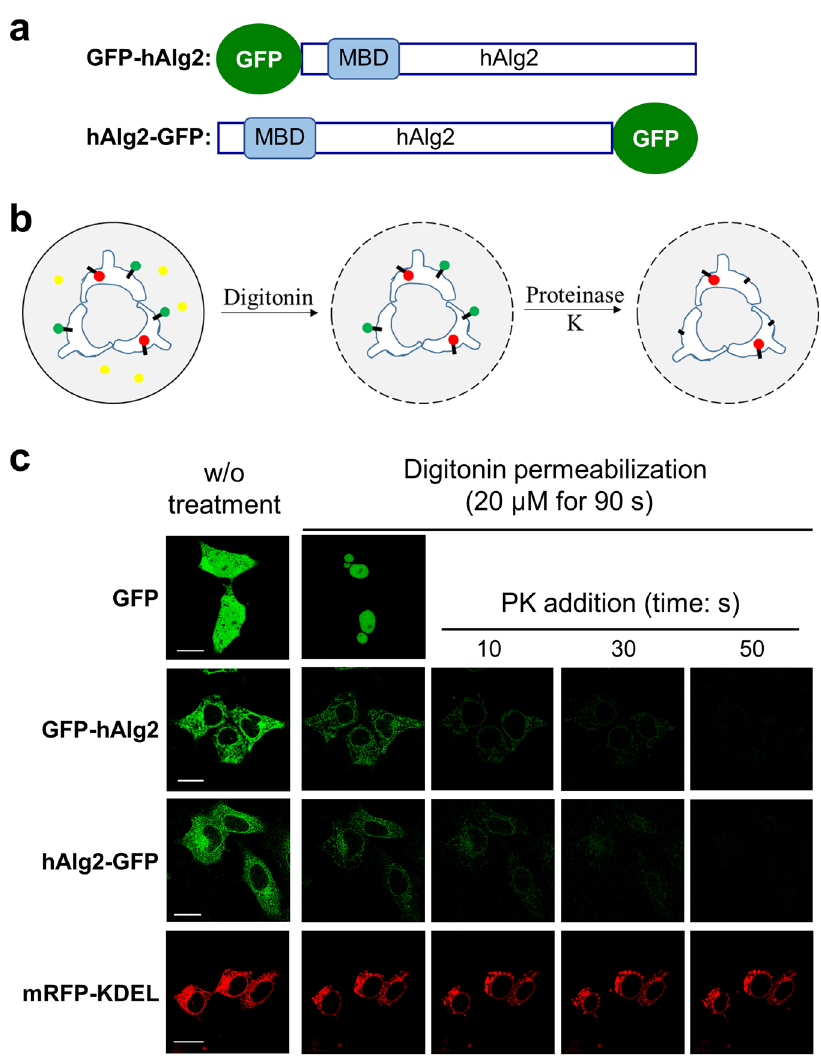
Fig. 3 Con fi rmation of the cytosolic orientation of hAlg2 termini with fl uorescence protease protection (FPP). a Schematic representation of the GFP- hAlg2 and hAlg2-GFP constructs. b Mechanism of FPP assay. Green dots: GFP tags that face the cytosol; Red dots: RFP tags that face the ER lumen. c FPP assay of HEK293 cells express GFP, GFP-hAlg2, hAlg2-GFP or mRFP-KDEL. The digitonin treatment was carried out at a concentration of 20 µ M for 90 s as permeabilization state for all experiments. Bar, 20 µ